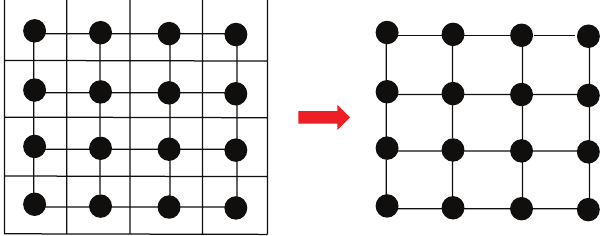
Figure 1: Partitioned layout into 𝑁 𝑥 × 𝑁 𝑦 rectangular array.